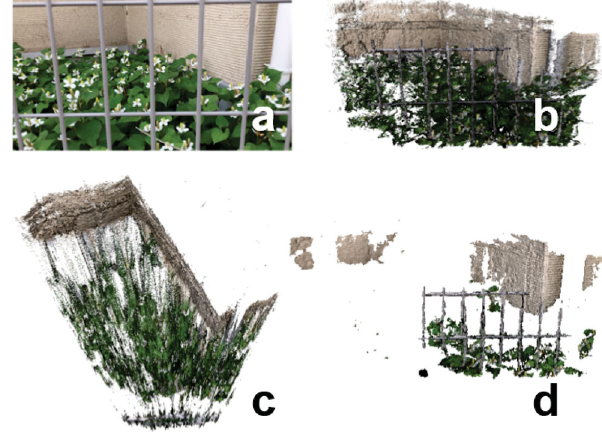
Fig. 2 Scene reconstruction from SfM: (a) a frame from a video sequence, (b) front view of a recovered 3D point cloud with color, (c) top view of the same, (d) 3D background